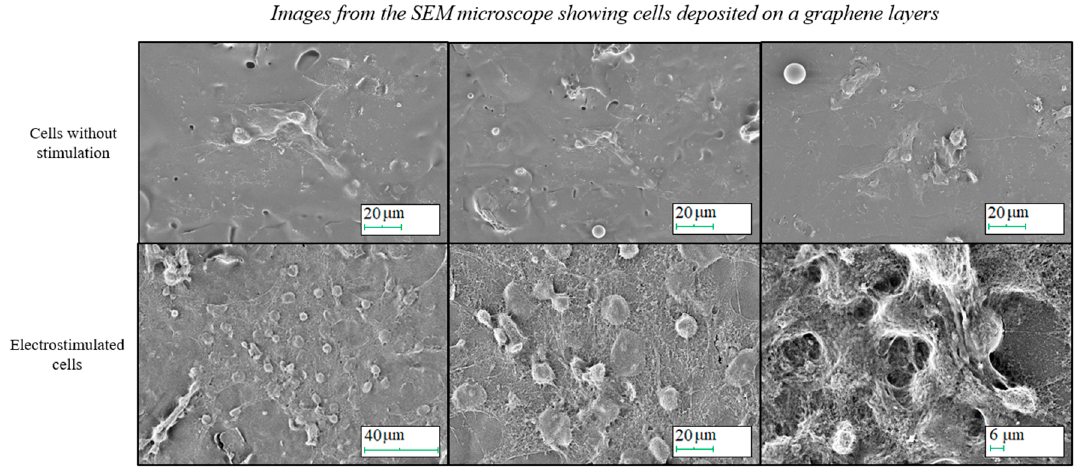
Figure 7. The SEM microscope images presenting the preliminary electrostimulation